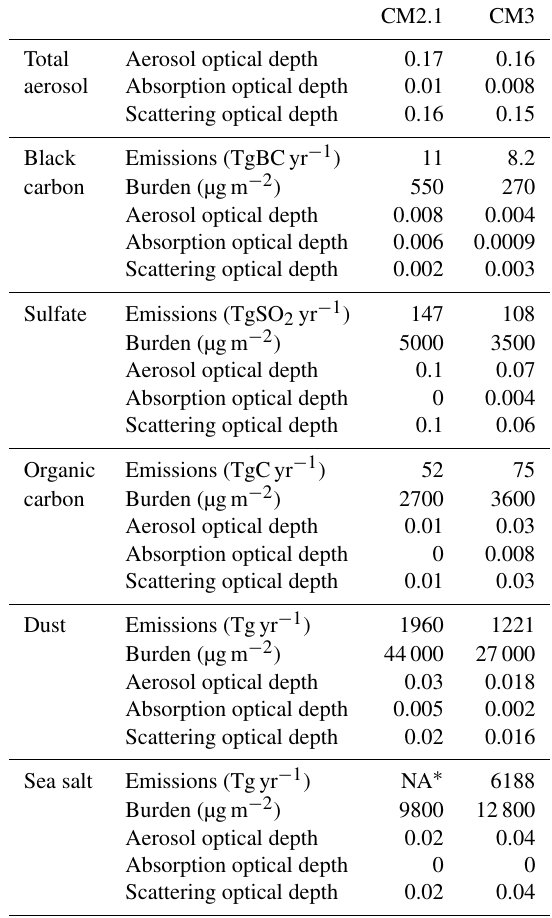
Table 1. Global mean present-day aerosol properties as